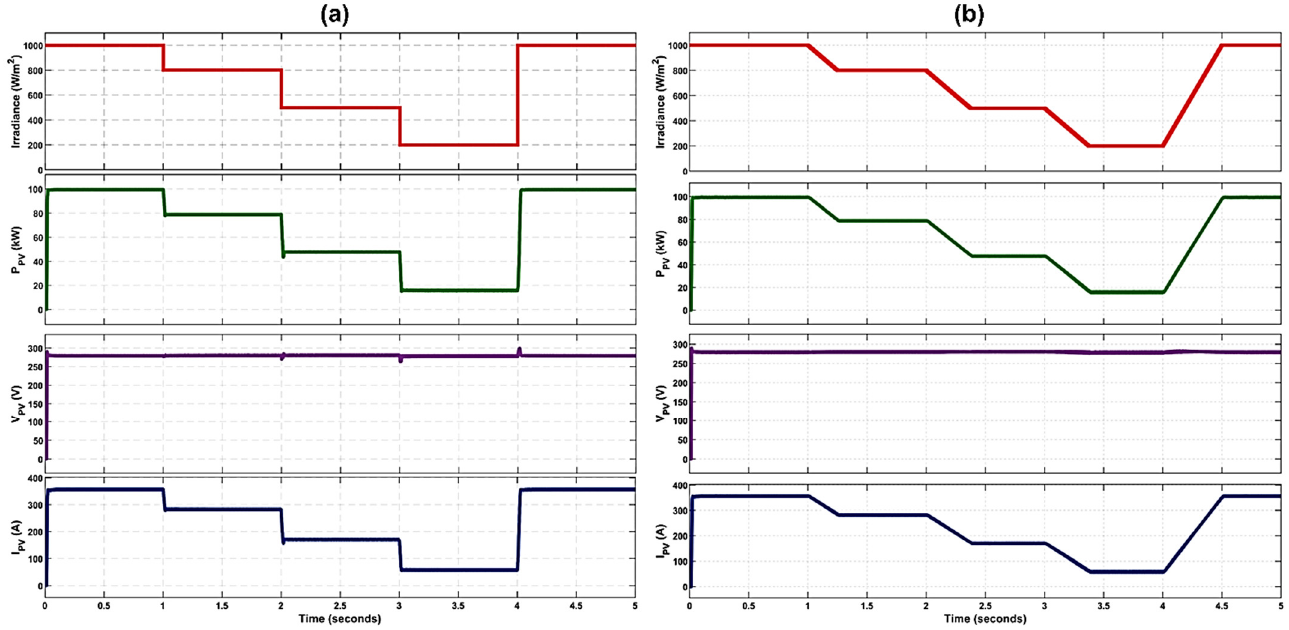
Figure 15. Variation of PV power, voltage, and current in cases of ( a ) abrupt and ( b ) progressive variations of solar irradi- ance.